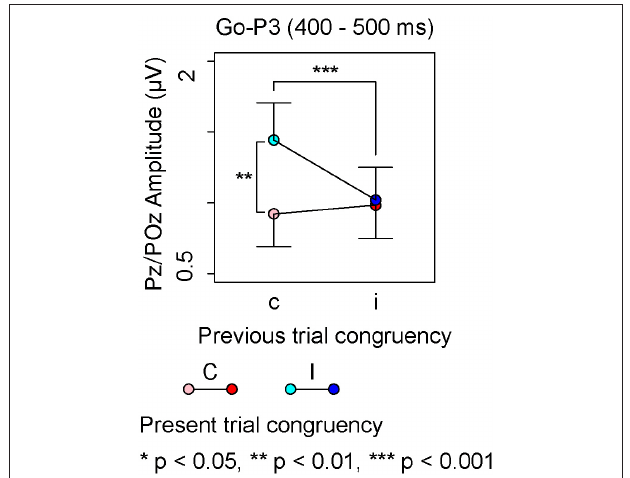
FIGURE 4 | The main results of ERP components for Go-stimuli; “c” and “C” represent congruent stimuli on previous and present trials, respectively. “i” and “I” represent incongruent stimuli on previous and present trials,